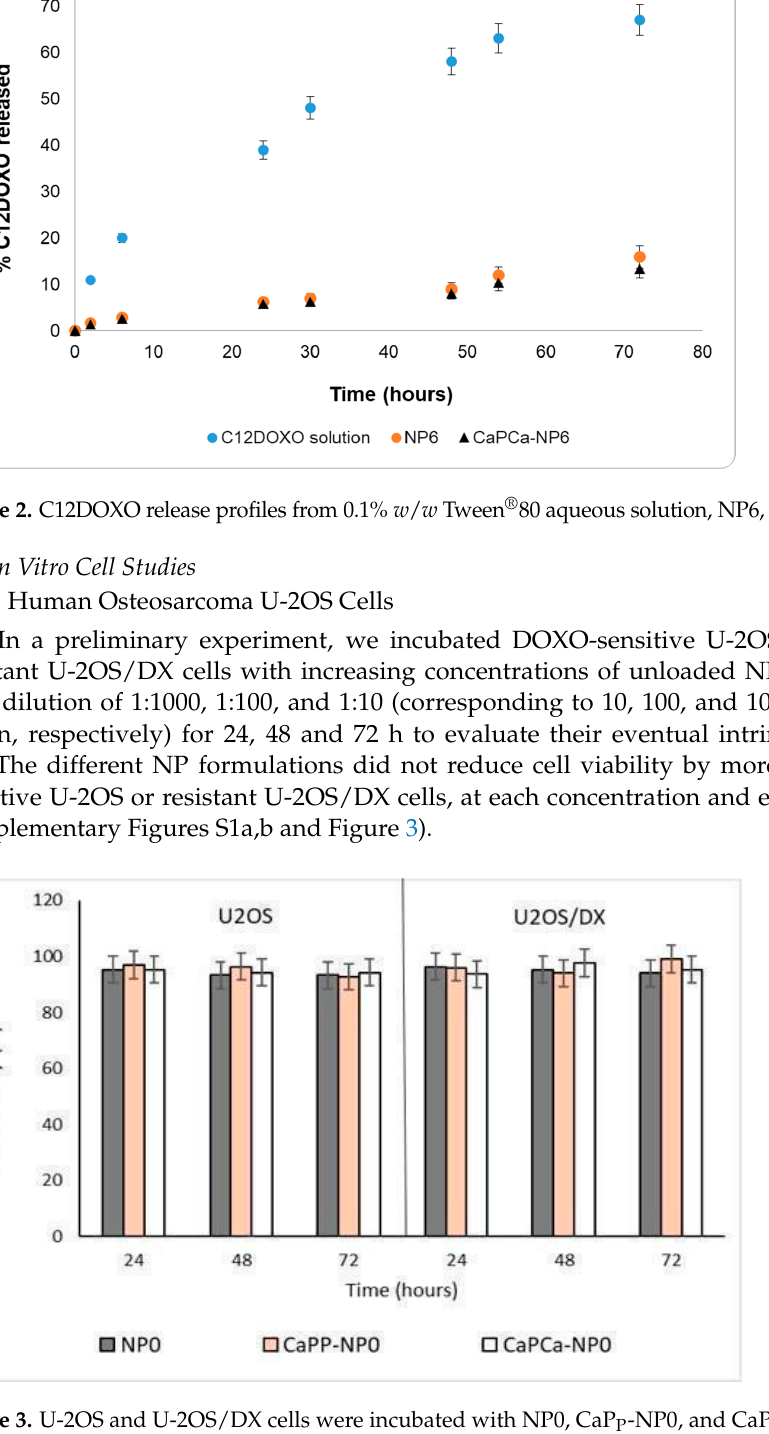
Figure 3. U-2OS and U-2OS/DX cells were incubated with NP0, CaP P -NP0, and CaP Ca -NP0, diluted 1:10 (1000 µg/mL trilaurin) in the cell culture medium, for 24, 48 and 72 h. Cell viability was meas- ured using the MTT assay. Results are means ± SD ( n = 3). using the MTT assay. Results are means ± SD ( n =